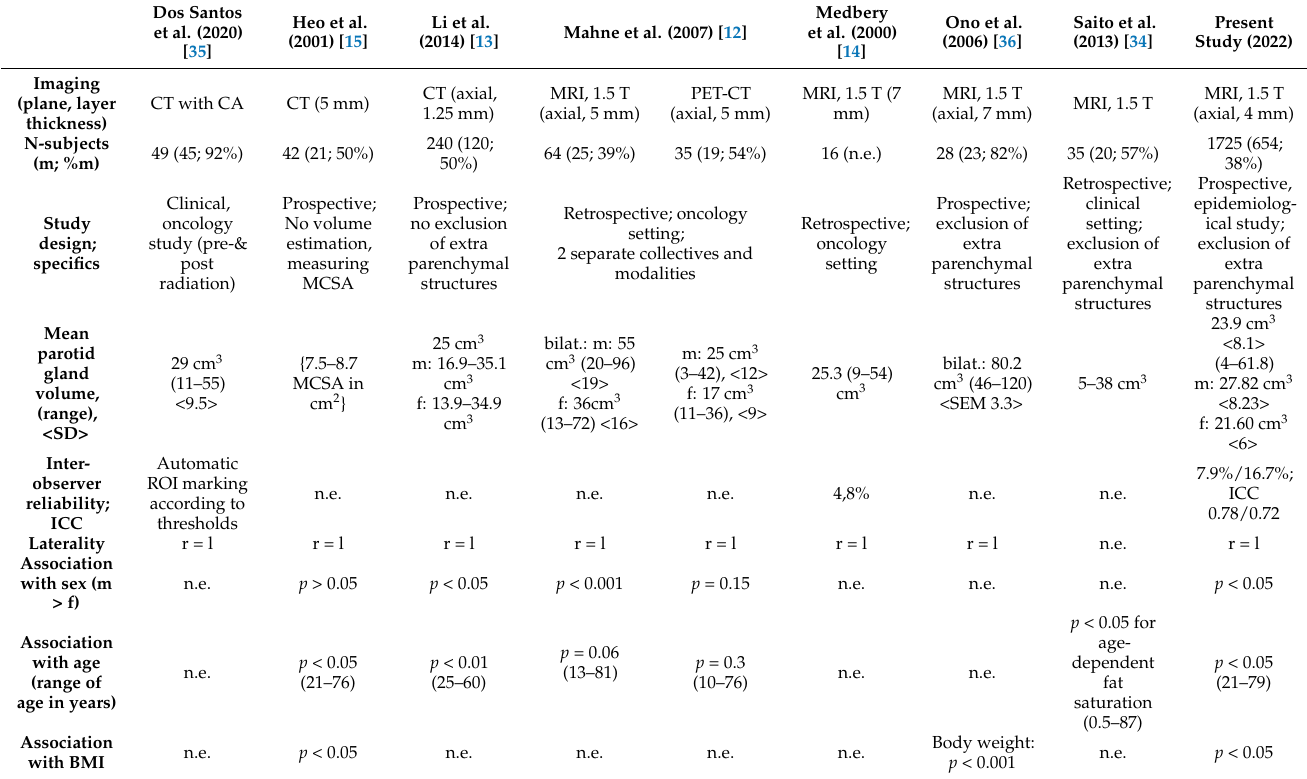
Table 4. Comparison of imaging studies describing the volume of the parotid gland and other